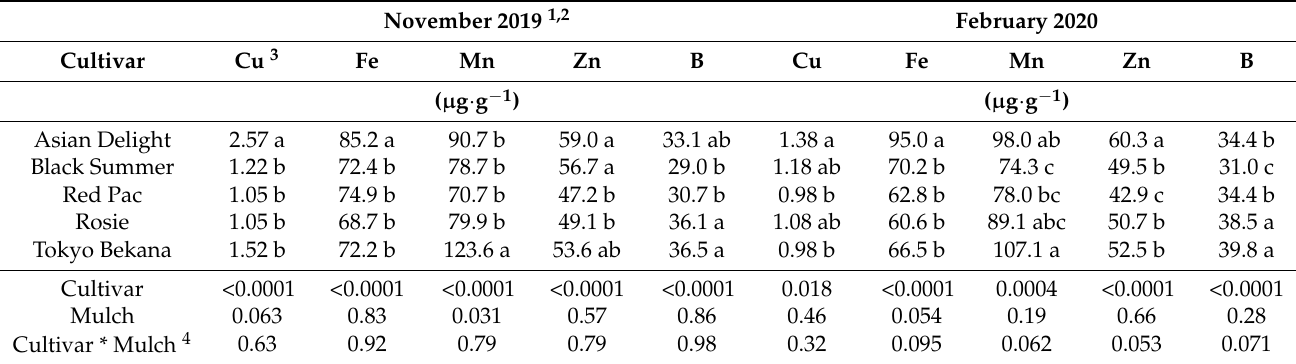
Table 7. Micronutrient concentrations in five Asian green cultivars grown with four types of mulches in a high tunnel in Starkville, MS in two